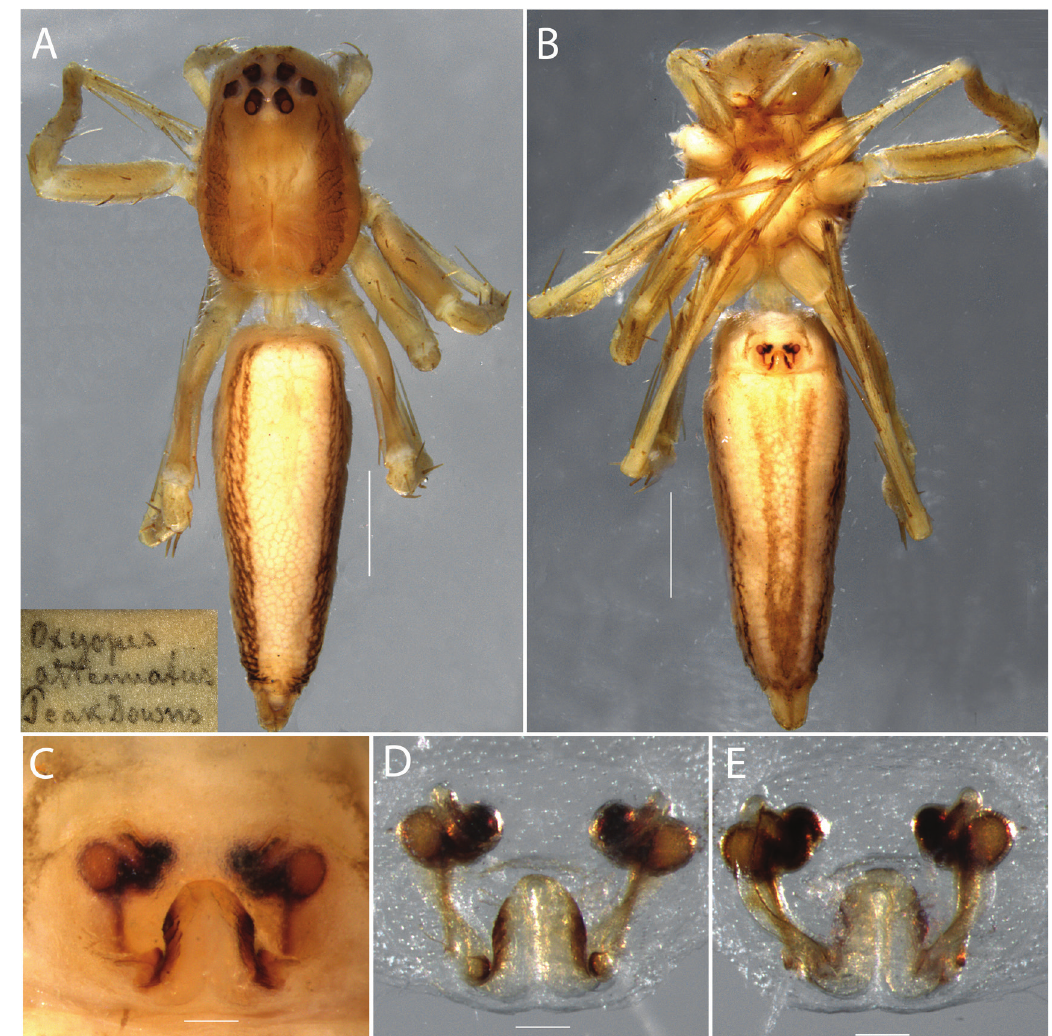
Figure 5. Oxyopes attenuatus L. KOCH 1878 , female holotype ( ZMH- A0000005): A , habitus, dorsal view; B , habitus, ventral view; C , epigyne, ventral view; D, epigyne, ventral view, cleared; E , epigyne, dorsal view, cleared. Scale bars: habitus 1.0 mm, epigyne 0.1